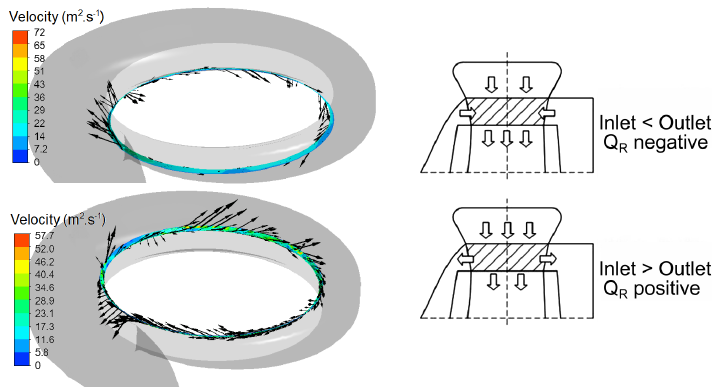
Figure 9. Velocity directions at different tangential positions. CFD results left according to [57], schematic right [58].